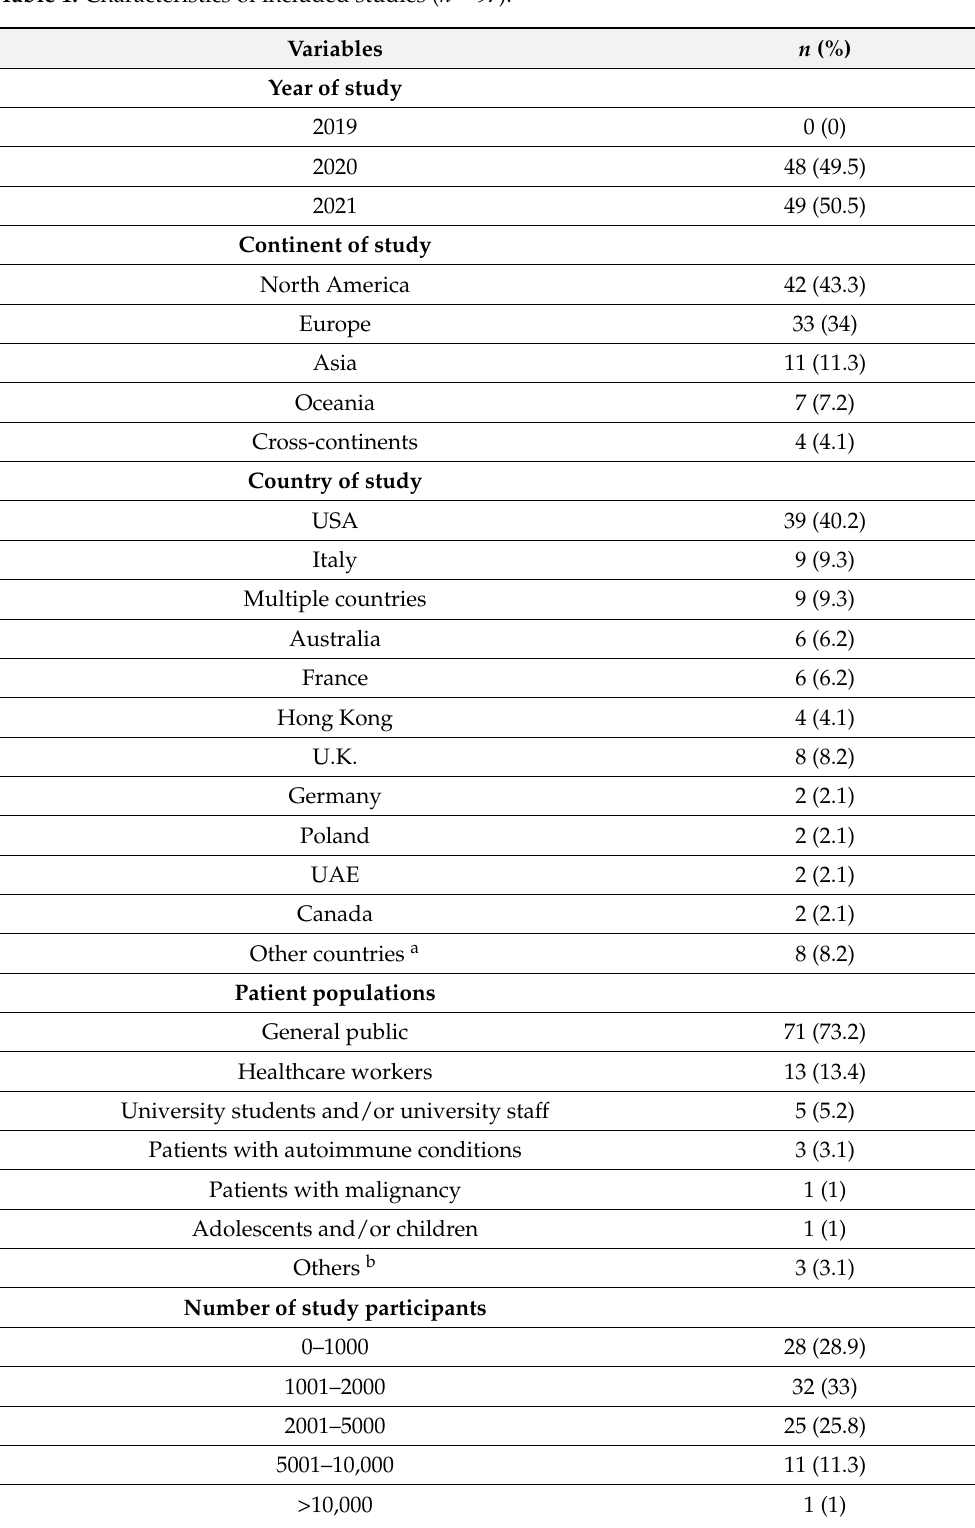
Table 1. Characteristics of included studies ( n =